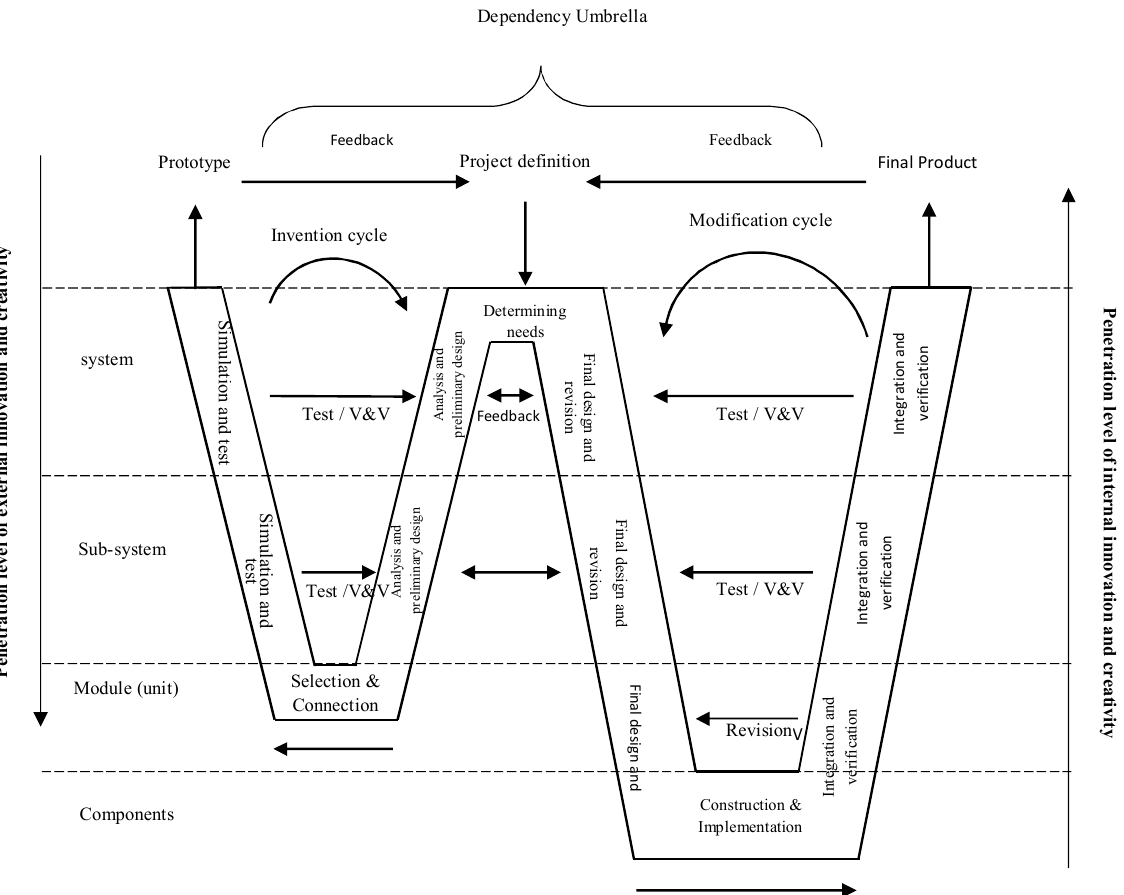
Fig. 8. Proposed W-model for integrated and agile design and development of mechatronic